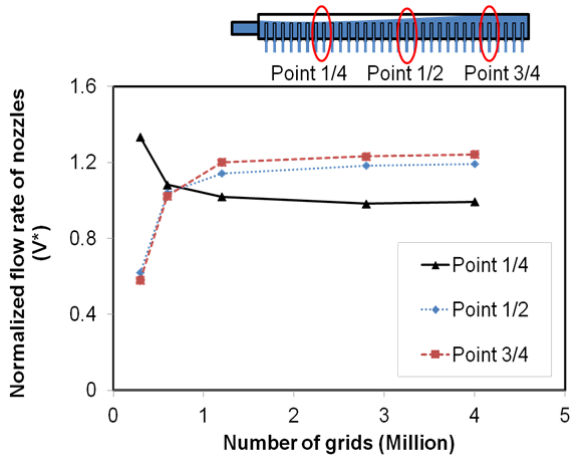
Figure 3. Normalized flow rate of simulation vs. number of